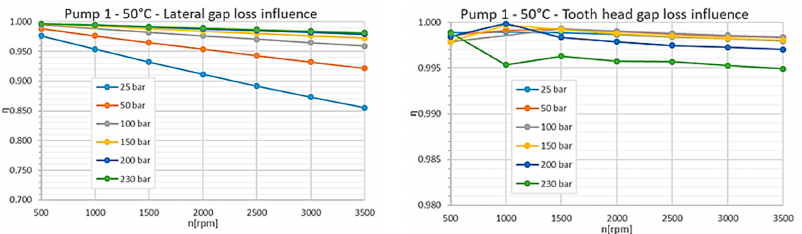
Figure 11. Calculated mechanical efficiency for pump 1 at 50 °C considering one type of loss at a time.